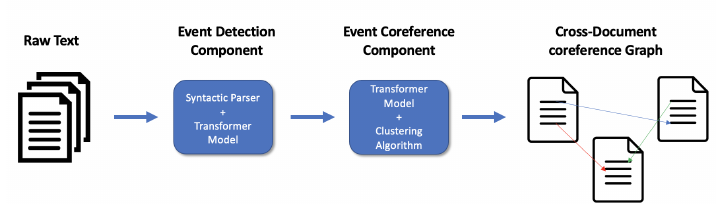
Figure 1. Schematic representation of the pipeline